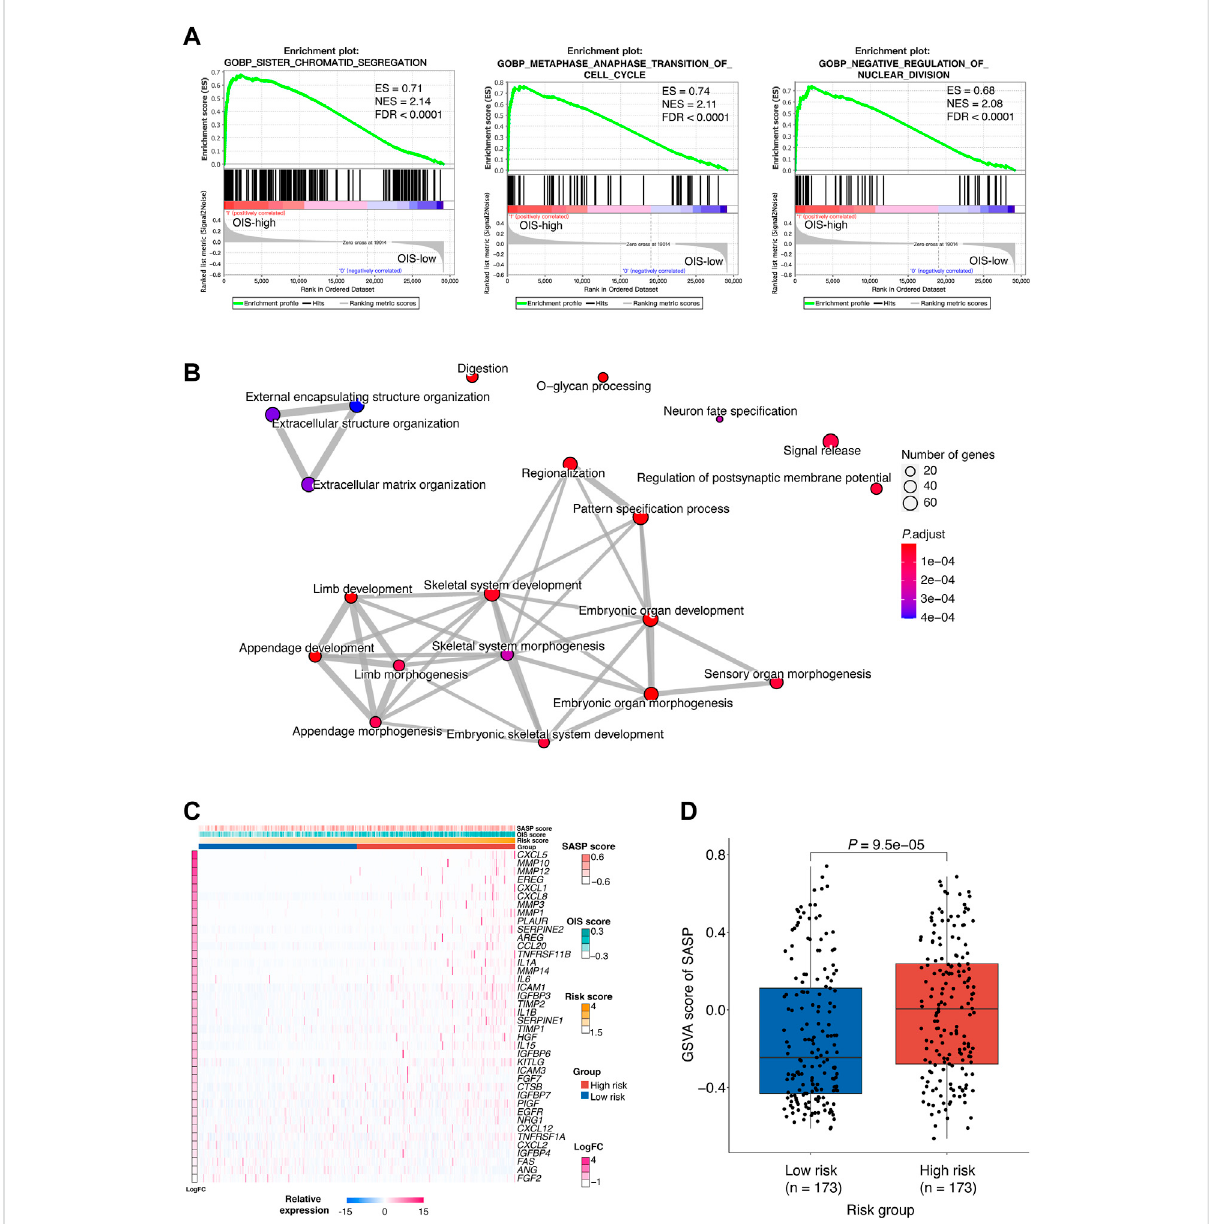
FIGURE 5 Biological implications of the OIS-related risk score (A) GSEA results of the signi fi cantly enriched signaling pathways in the HCC patients with high-risk. GSEA was carried out using expression data of TCGA-LIHC tumors. The ESs, NESs and FDRs were determined by GSEA. (B) Network diagrams of the enriched signaling pathways with p < 0.05. Enrichplot analysis was used to create the network diagrams. The number of genes included in the pathway is represented by the size of the circle, and the number of genes shared by the connected pathways is shown by the thickness of the line. (C) A heatmap of the expression levels of SASP-related genes in HCC tumors from TCGA. (D) GSVA scores of SASP in the high- andlow-riskgroups.The p valuewasassessedbyWilcoxtest.GSEA,genesetenrichmentanalysis;HCC,hepatocellularcarcinoma;TCGA,thecancer genome atlas; ES, enrichment score; NES, normalized enrichment score; FDR, false discovery rate; SASP, senescence-associated secretory phenotype; GSVA, gene set variation